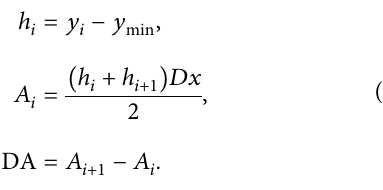
Figure 6: Fitting curves between statistical parameters and JRC. (a) Z